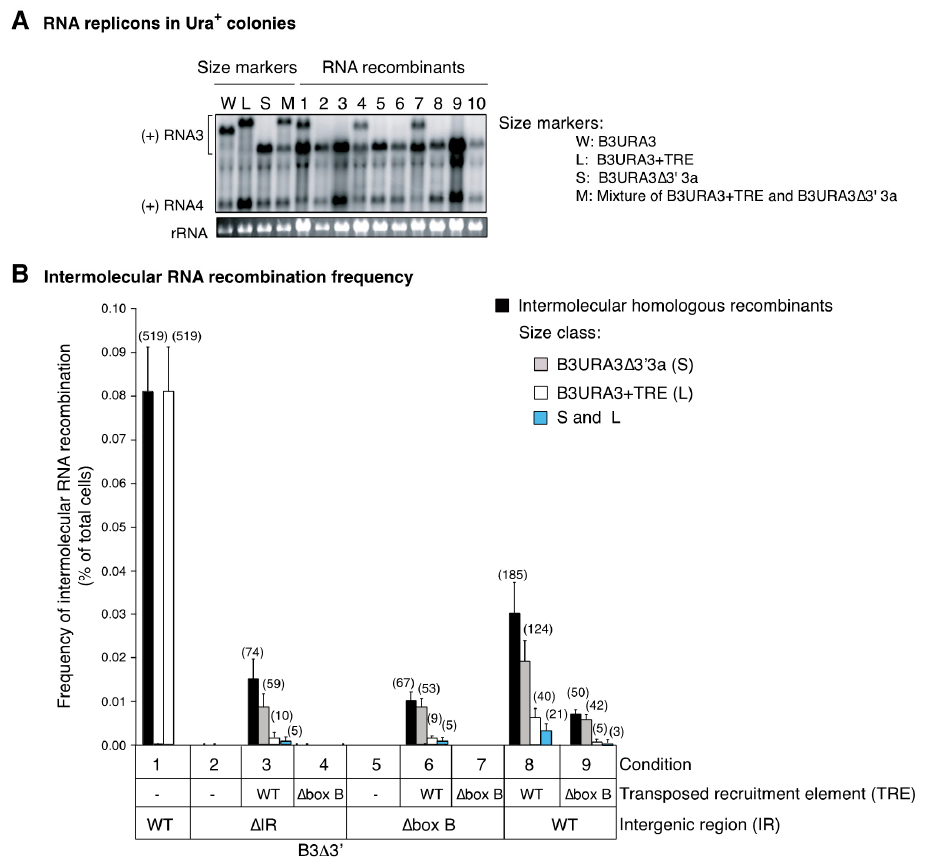
Figure 5. Intermolecular RNA recombinants from acceptor RNAs harboring a transposed recruitment element. ( A ) Sample Northern blot of intermolecular RNA recombinants between B3 ∆ 5 ′ and B3 ∆ 3 ′∆ IR + TRE. B3URA3, B3URA3 + TRE (L), B3URA3 ∆ 3 ′ 3a (S), and a mixture of L plus S were used as size markers. Positive strand (+) RNA3 and RNA4 were detected with 32-P-labeled probes against URA3. Two size classes were identified. Short B3URA3 ∆ 3 (cid:48) 3a (2, 3, 5, 6, 8, 9 and 10), long (L) B3URA3 + TRE in combination with B3URA3 ∆ 3 (cid:48) 3a (1, 4 and 7) or alone. Ethidium bromide staining